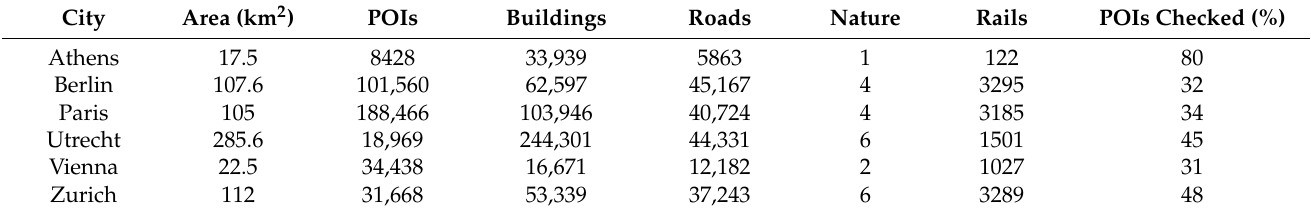
Table 1. Area covered for each city, number of features in each thematic layer, and percentage of POIs checked. City Area (km 2 ) POIs Buildings Roads Nature Rails POIs Checked (%) 8428